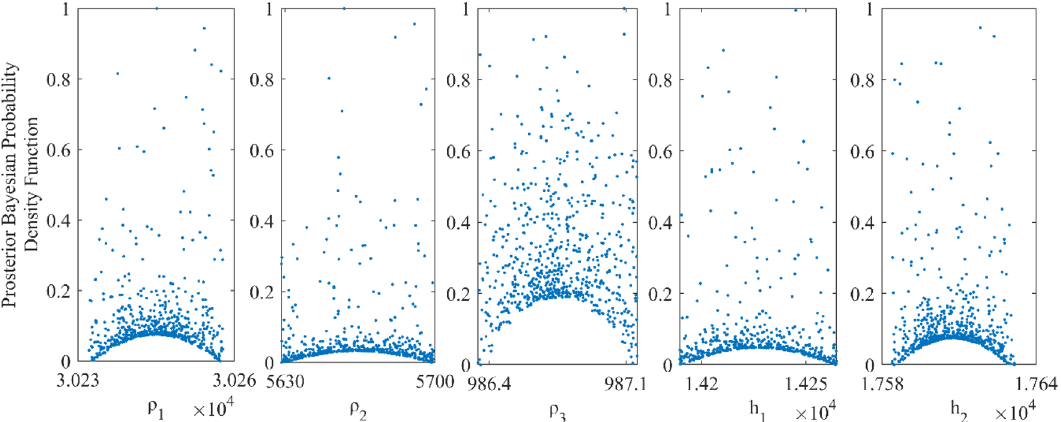
Figure 8. Bayesian posterior probability density function ( bpdf ) versus vPSOGWO inverted layer parameters for three-layered noisy MT synthetic data.